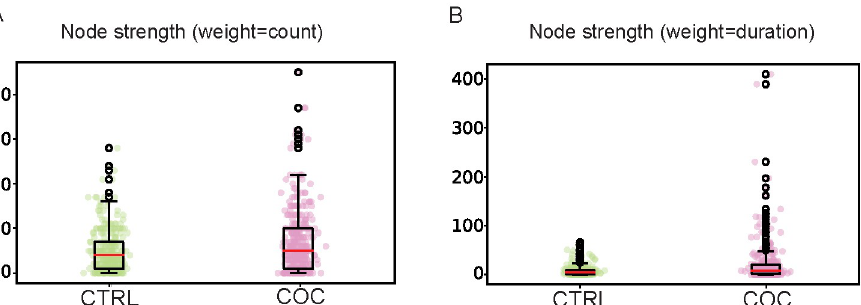
Fig 5. Information centrality indicate smaller number of hubs in CTRL networks. A) Box plot of median values for nine CTRL networks (n = 270 flies) grouped, which were given regular food, and eleven COC networks (n = 330 flies) grouped, which were orally administrated 0.50 mg/mL of cocaine for 24 hours before tracking. Data are extracted from 10 minute videos using FlyTracker and analyzed using NetworkX. Statistical analysis was performed using independent-samples t -tests with Welch-correction since group sizes are different. p- value less than 0.05 is taken as significant presented in S1 Table. B) Box plot of nine CTRL networks (n = 270 flies) grouped on the regular food and eleven COC networks (n = 330 flies) grouped and orally administrated to 0.5 mg/mL of cocaine for 24 hours before tracking. Data are extracted from 10 minute videos using FlyTracker and analyzed using NetworkX. C) Histogram for average information centrality from nine CTRL networks (n = 270 flies) grouped on the regular food. D) Histogram for average information centrality from eleven COC networks (n = 330 flies) grouped and orally administrated to 0.5 mg/mL of cocaine for 24 hours before